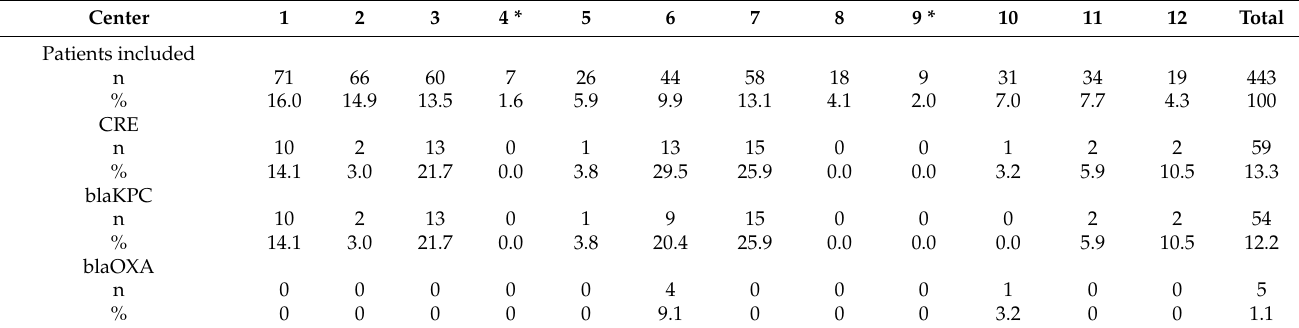
Table A1. Number of patients included in each center and resistant mechanisms in CRE isolates.